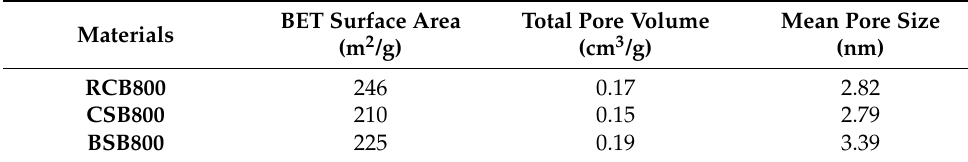
Table 2. Texture properties of biochar